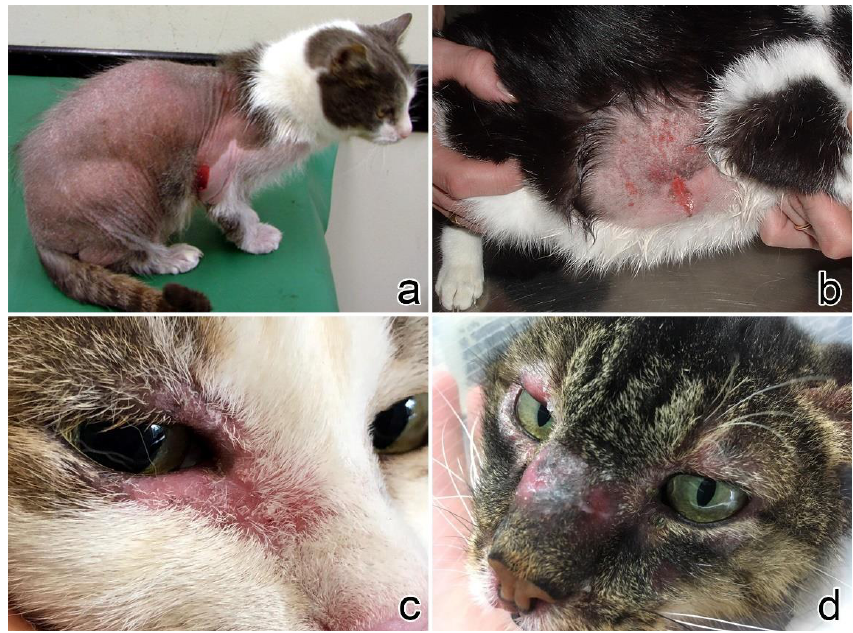
Figure 1. Clinical signs in cats. ( a ) Case no. 3: generalized alopecia and scales (courtesy Dr. Fabrizio Fabbrini). ( b ) Case no. 4: focal alopecia with multifocal ulcers on the abdomen (courtesy Dr. Alessandro Corona). ( c ) Case no. 3: erythema, alopecia, and scales on both right eyelids (courtesy Dr. Sivia Colombo). ( d ) Case no. 14: alopecia, erythema, and swelling of the nose and eyelids (courtesy